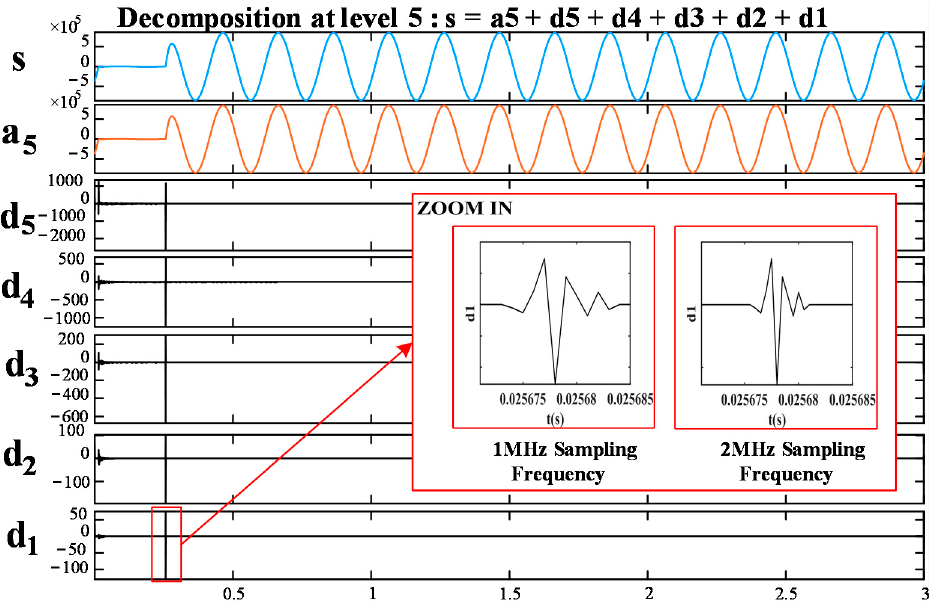
Figure 7. Wavelet decomposition structure.